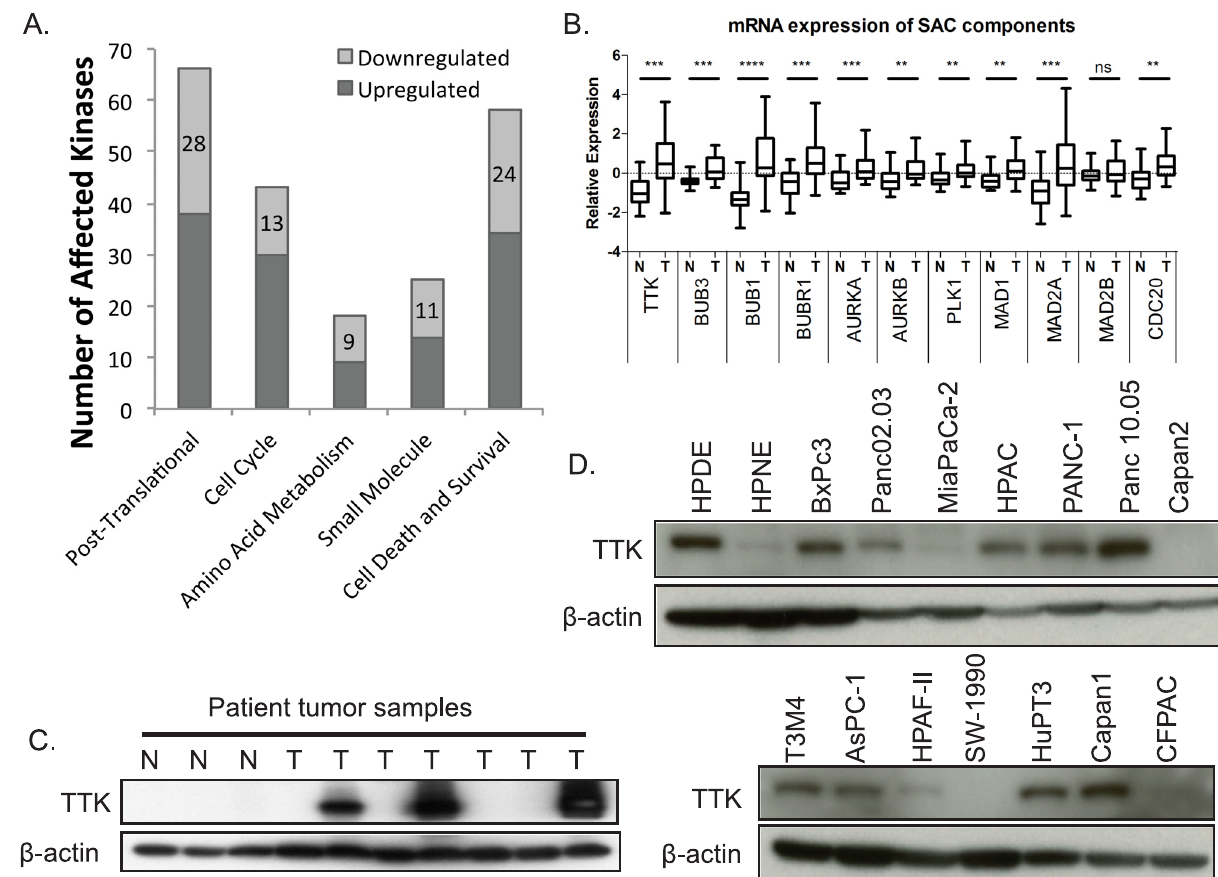
Fig 1. Increased expression spindle assembly checkpoint components and its regulator TTK in PDAC. (A) IPA software identified prominentcellularfunctions that were significantly affected by differentiallyexpressedkinasesbetweennormal and primary PDAC. (B) Box and whisker plot of median,upper, and lower quartilesof mRNA expressionof core components and regulatorsof the spindleassembly checkpoint.Asterisk represent the p-value of the Mann-Whitney test (ns: p (cid:21) 0.05, ** : p (cid:20) 0.01, *** : p (cid:20) 0.001, **** : p (cid:20) 0.0001). (C) Expression of TTK in a panel of patient samples. N = normalpancreas and T = primary tumor. (D) Expressionof TTK in immortalized pancreas epithelium (HPNE and HPDE) and PDAC cell lines.